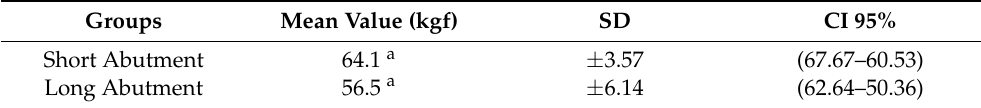
Table 2. Mean value ± standard deviation (SD) of the data obtained by resistance in the analysis of maximum load for fracture for the titanium implant group with long PEEK abutment and